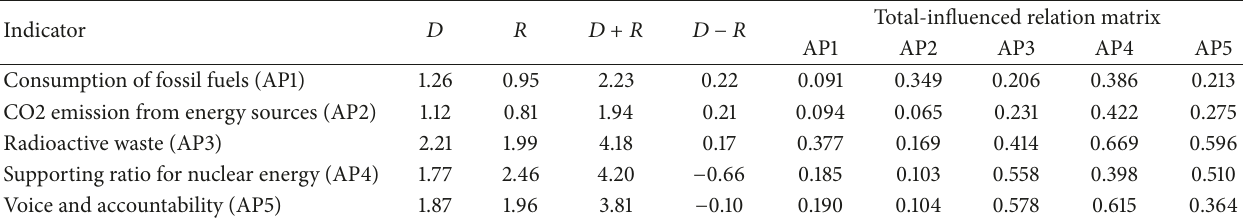
Table 14: The result of Fuzzy-DEMATEL analysis for Acceptability (Case 2 ).